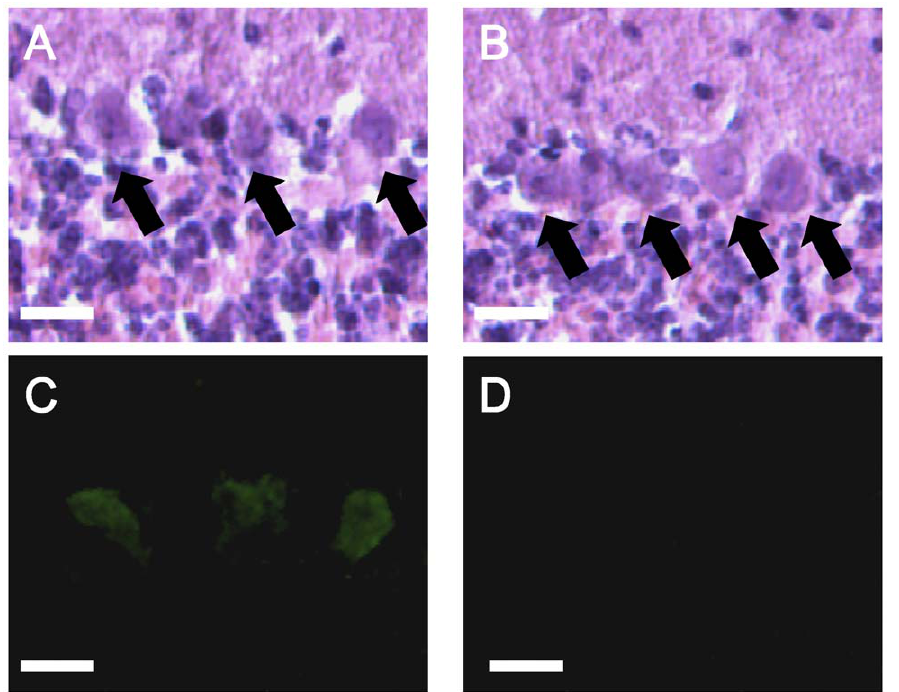
Figure 4. Representative histochemistry in the cerebellum of tottering-6j mice. Hematoxylin eosin (HE) staining of 6j/6j (A) and + / + (B) cerebella, and tyrosine hydroxylase (TH) staining of 6j/6j (C) and + / + (D) cerebella are shown. TH was detected in the Purkinje cells of the 6j/6j mice ( n= 6) but not in those of + / + mice ( n= 6). Arrows point to Purkinje cell somata. Scale bar, 20 m m.